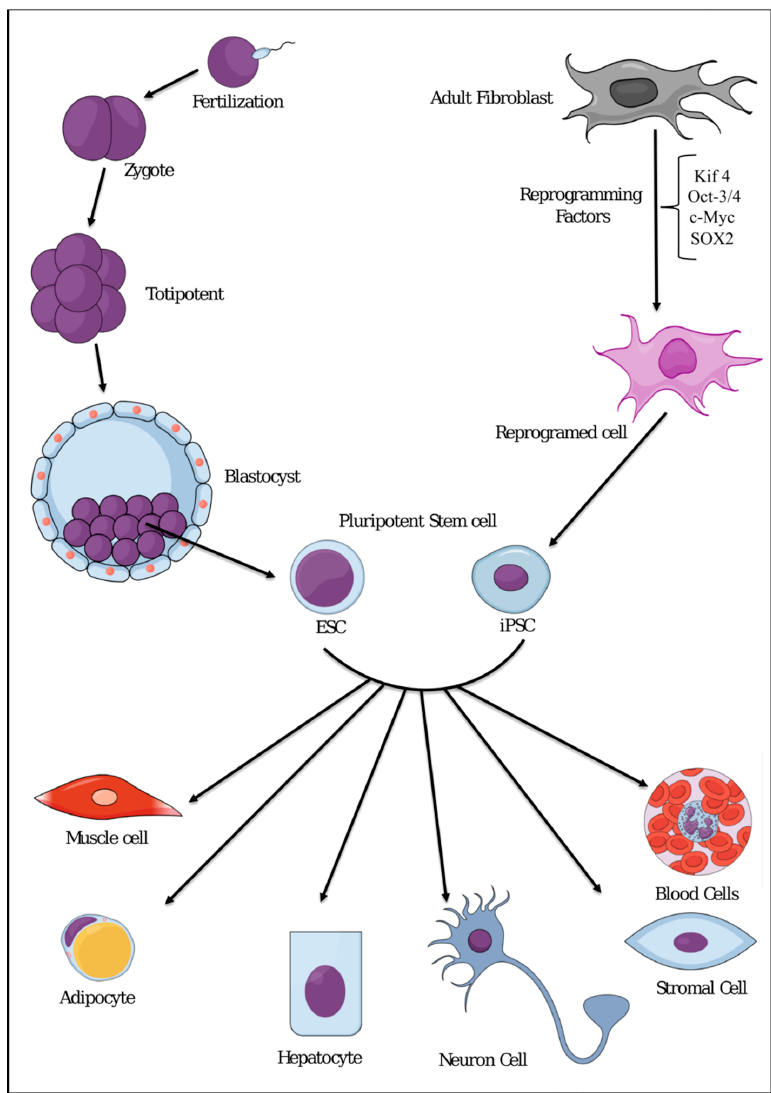
Figure 2. Representative scheme showing differentiation potential of pluripotent stem cells such as embryonic stem cells (ESCs) or induced pluripotent stem cells (iPSCs) into all cell types.